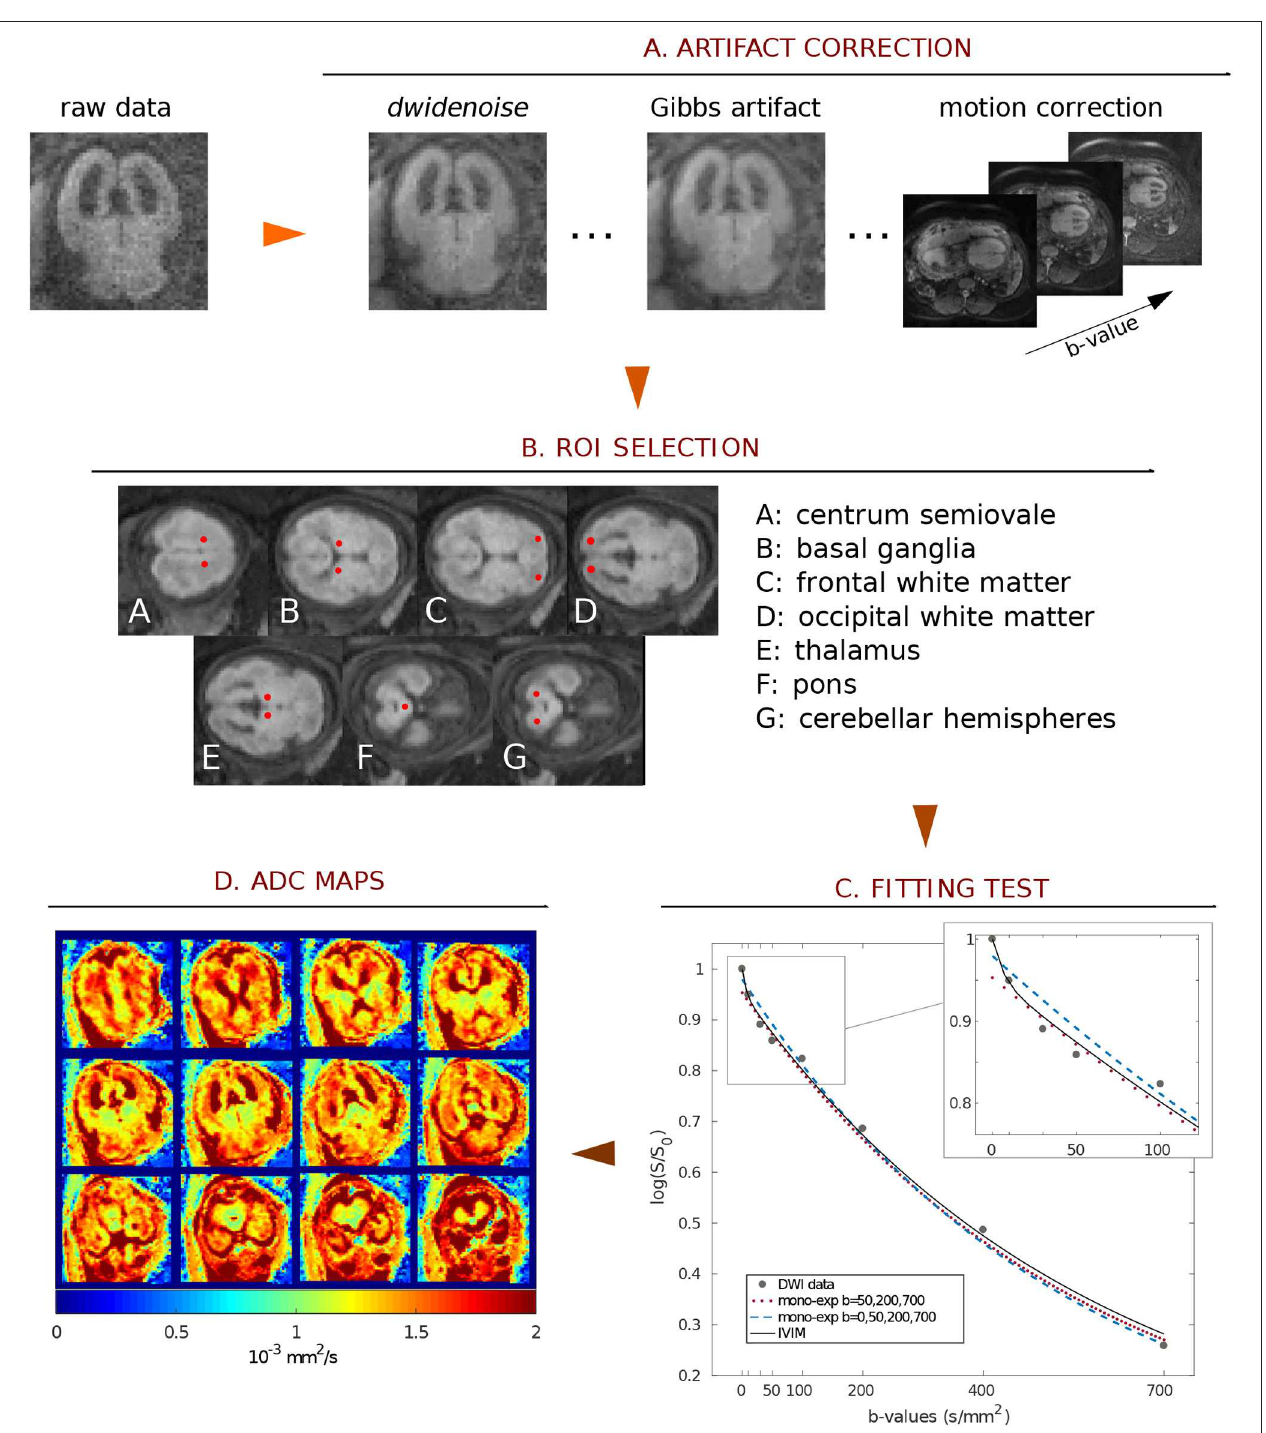
FIGURE 1 | Scheme of image analysis. (A) Raw images were first corrected for noise, Gibbs, and motion artifacts. (B) Seven ROIs were manually drawn. (C) In preliminary tests on 3 subjects we compared 3 fitting procedures to evaluate perfusion effects of DWI signal: 2 mono-exponential fit (with b -values = 50, 200, 700 s/mm 2 and b -values = 0, 50, 200, 700 s/mm 2 ) and an IVIM fit (with b -values = 0, 10, 30, 50, 100, 200, 400, 700 s/mm 2 ). The magnification highlights the greater slope of the mono-exponential fit with b = 0 caused by perfusion. (D) Finally, ADC maps were calculated by mono-exponential fit with b -values = 50, 200, 700 s/mm 2